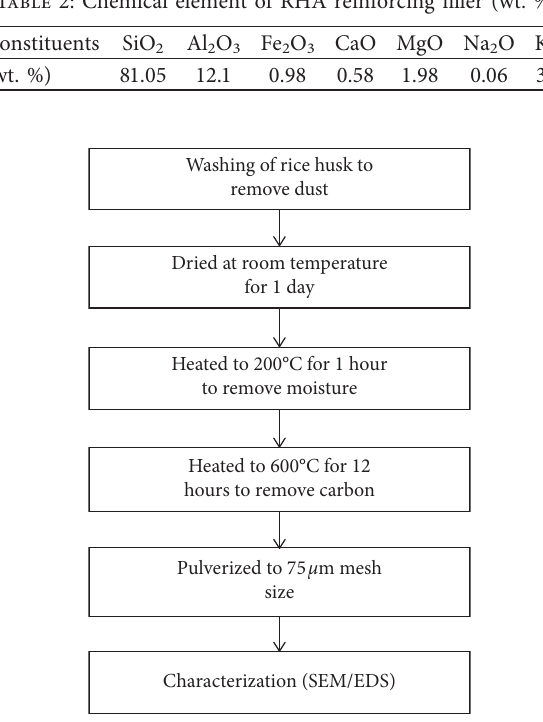
Figure 1: The flowchart for the processing of RHA.